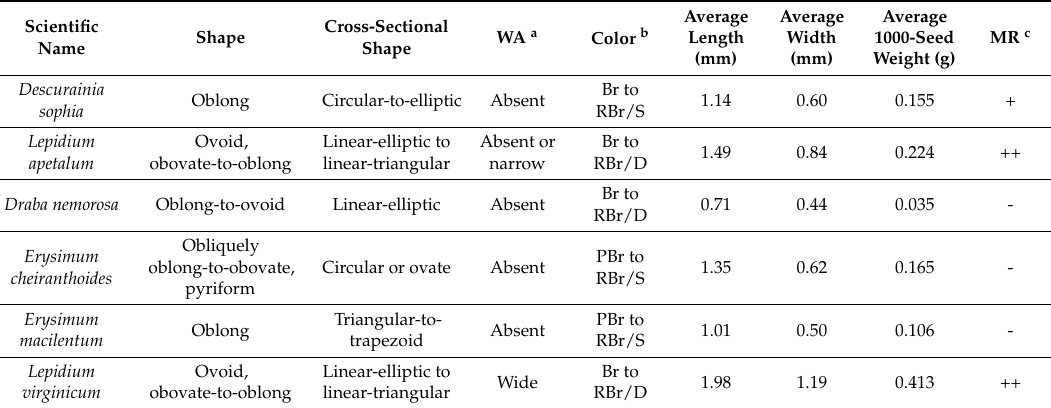
Table 2. Morphological characteristics of Descurainia sophia and Lepidium apetalum (authentic sources of Lepidii seu Descurainiae Semen) and adulterant